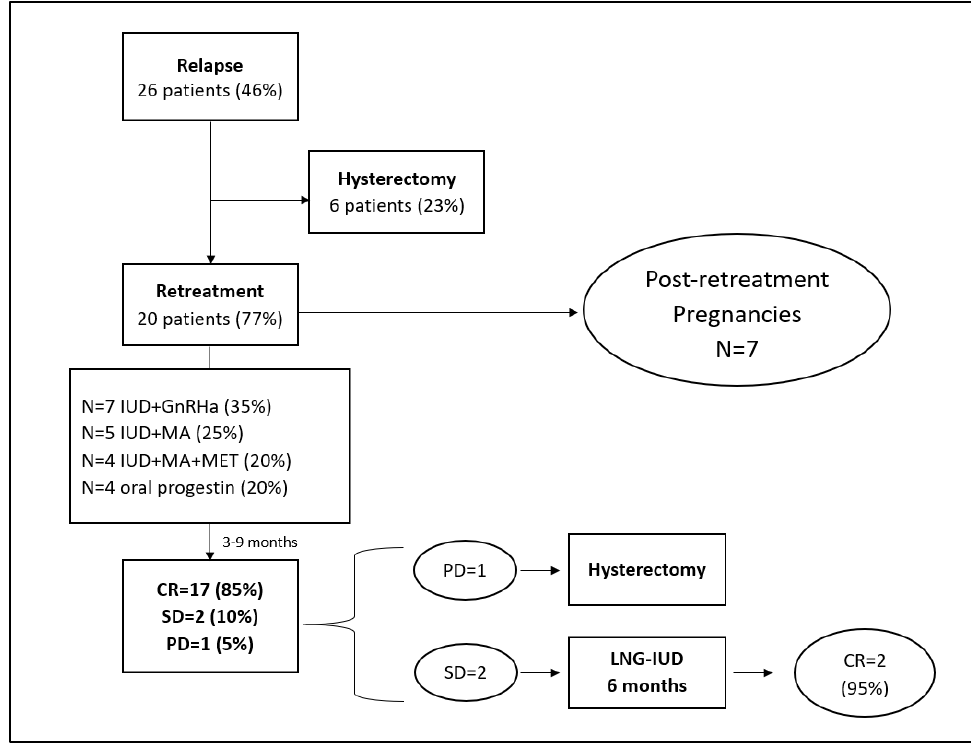
Figure 1. Flow chart of oncological and obstetric outcomes after retreatment. Table 1 provides an overview of the principal characteristics of the study population. Table 1. Patients’ characteristics: summary statistics of continuous and categorical variables a .